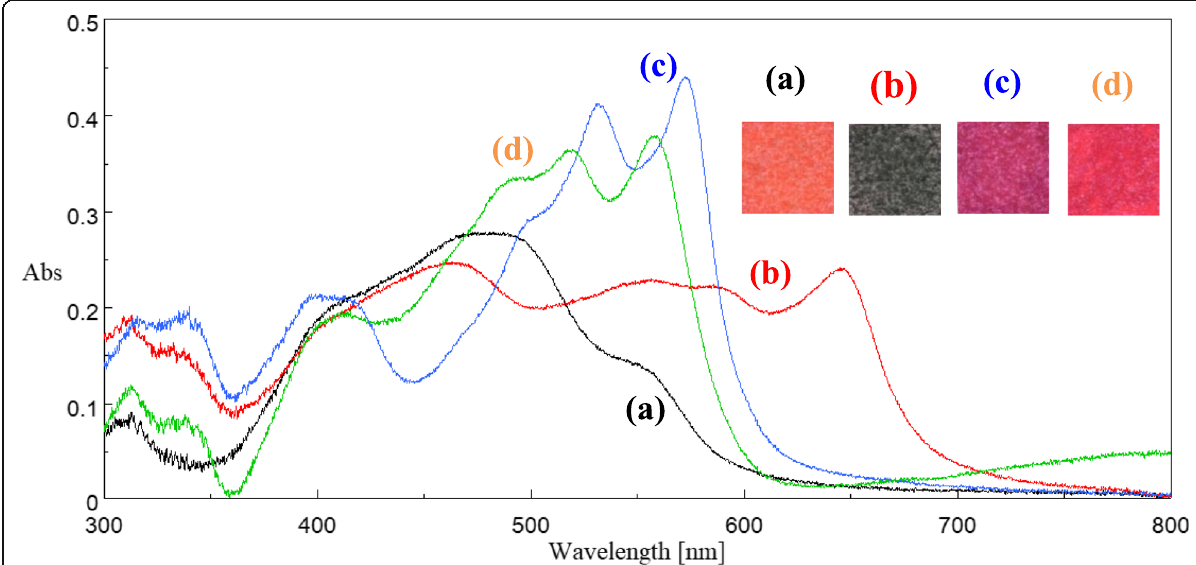
Fig. 6 UV-vis spectra and images of PAN-CC before (a) and after equilibration in Co(II) (b), Ni(II) (c), and Zn(II) (d)